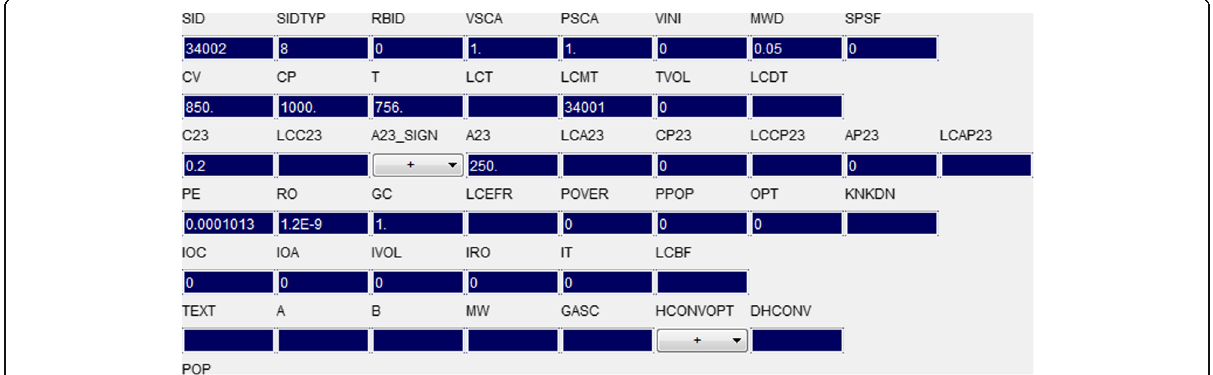
Fig. 9 Key cards of the inflatable model in